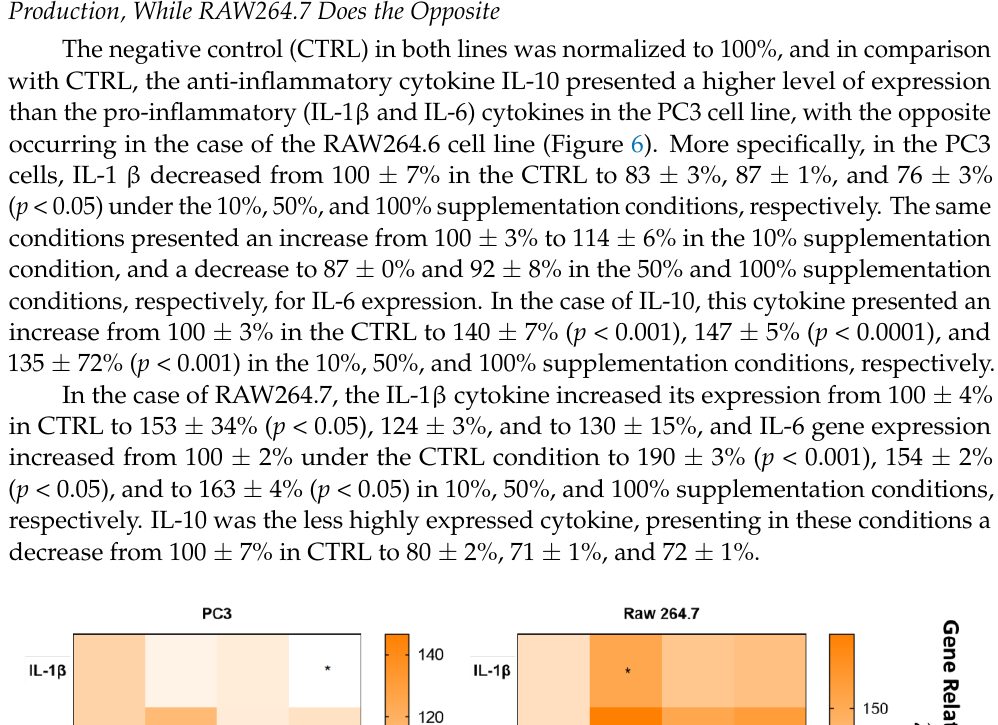
Figure 5. Cellular viability and proliferation of the PC3 and Raw264.7 cell lines after the 24 h and 48 h treatments. The results were compared with the CTRL condition (cells cultured in a culture medium without any serum) that was normalized to 100%. p values of <0.05 were considered to be statistically significant: * means p < 0.05; ** means p < 0.01; *** means p < 0.001 and **** means p < 0.0001.